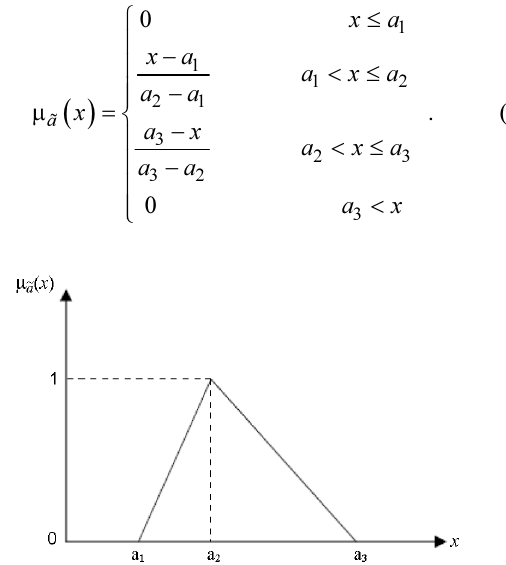
Fig. 1. A triangular fuzzy